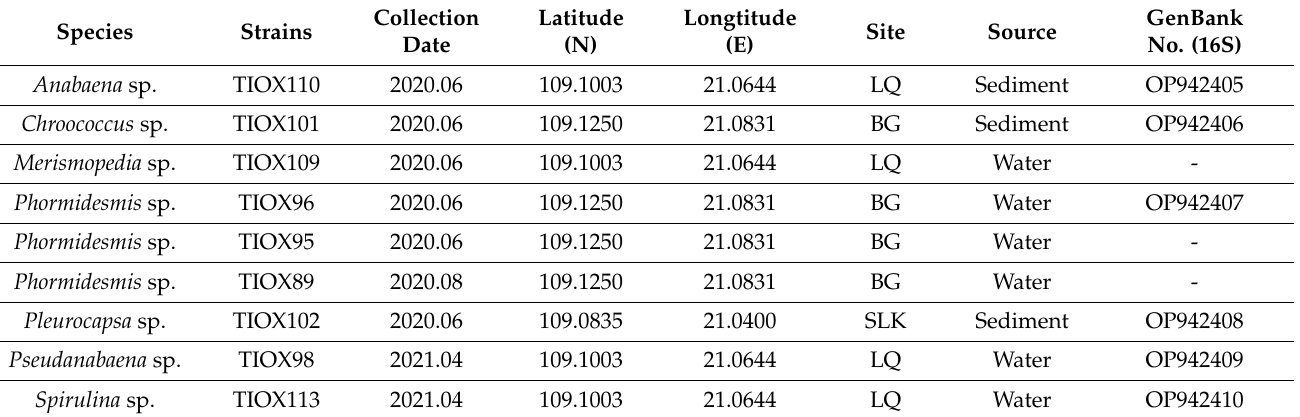
Table 2. Cyanobacterial strains cultured in the present study, including the collection date, coordi- nates, sampling site, and GenBank accession